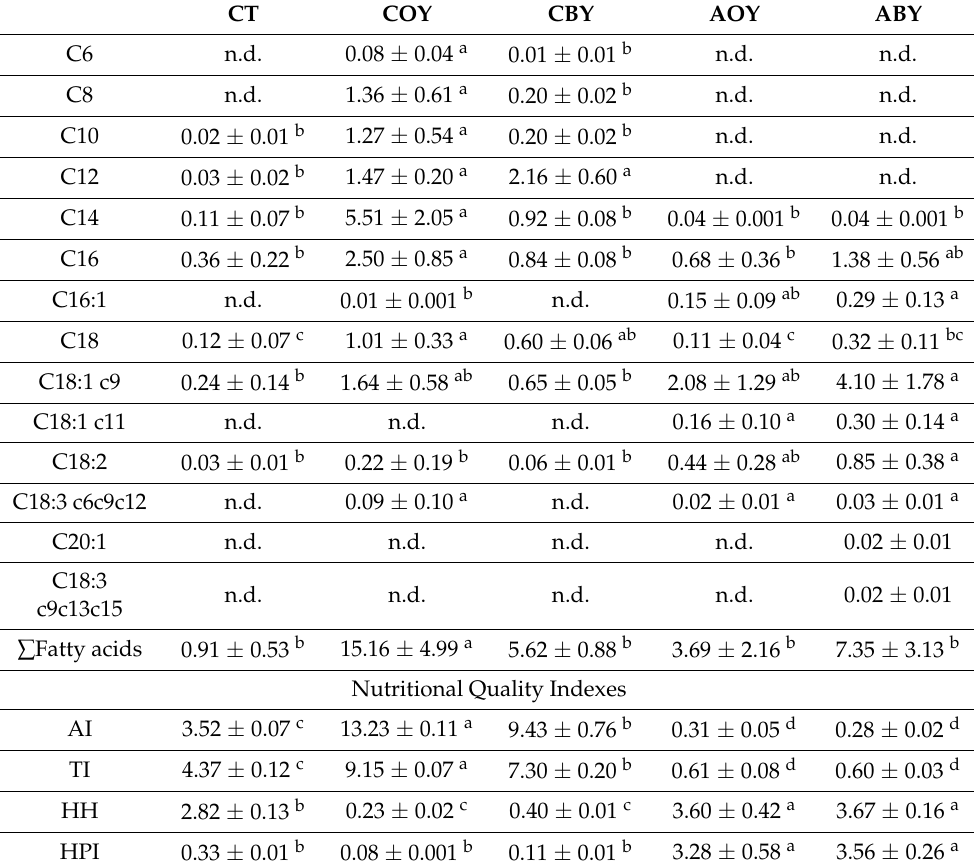
Table 1. Fatty acids profile of yogurts and their nutritional quality indexes. CT COY CBY AOY ABY